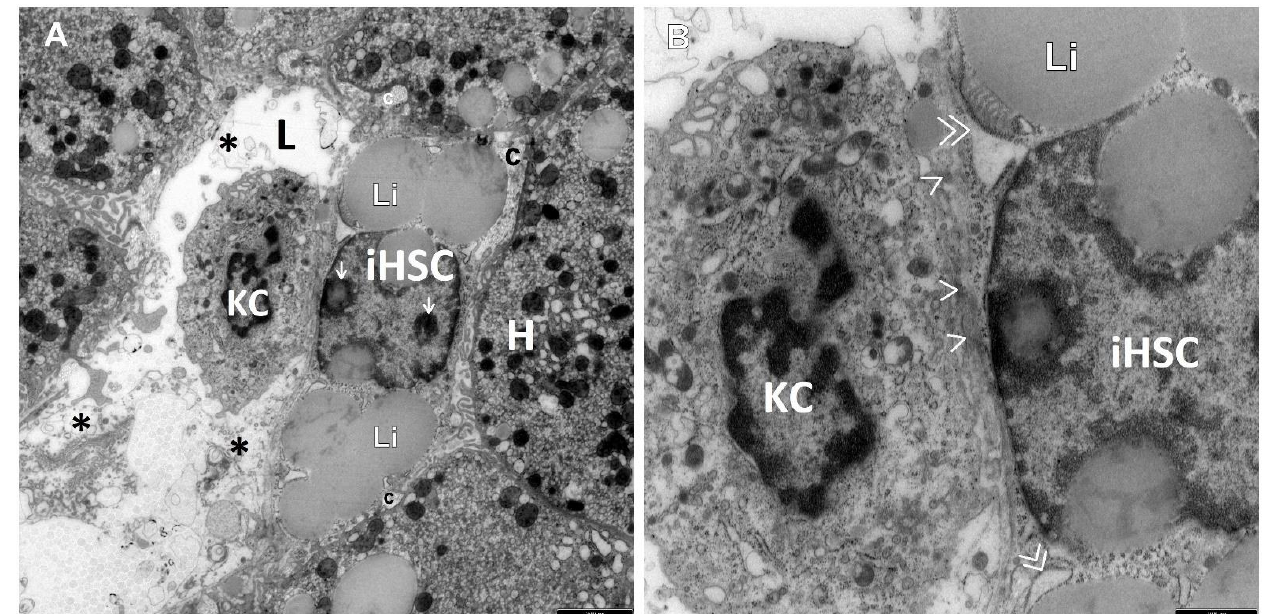
Figure 1. ( A , B ) A picture of a slightly elongated Q-HSC being transformed into T-HSC, which may correspond to the phase of activation initiation, i.e., iHSC, and an activated Kupffer cell (KC) that adheres tightly to it from the side of the sinusoidal vascular lumen in liver biopsy obtained from a child with AIH (S-1). Between these cells, there is a direct cell–cell contact by means of desmosomes (>), well visible at a larger magnification ( B ). The cell nucleus contains two activated nucleoli (->); the cell is rich in lipid material; and the cytoplasm shows slightly dilated granular endoplasmic reticulum (ger) channels (>>). A small number of mature collagen fibers (c) adhere focally to the iHSC. The vascular pole of hepatocyte (H) sends numerous microvilli towards the HSC. In the vicinity of KC, the sinusoid vascular lumen shows fragments of damaged liver sinusoidal endothelial cells (*). L—the lumen of liver sinusoid. Scale bar 2.5 µ m, original magnification × 4400 ( A ); 1 µ m, original magnification × 12,000 ( B